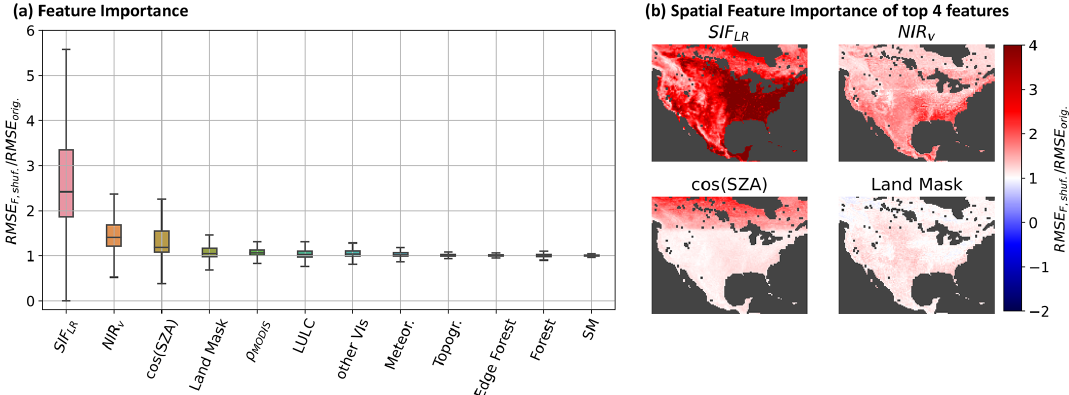
Figure 5. Feature importance. Panel (a) shows the total RMSE of the permuted feature divided by the RMSE without feature permutation, and (b) shows the RMSE of each pixel with permuted features divided by the RMSE without feature permutation. Some input variables are clustered, and all variables of that class are permuted at the same time. ρ MODIS : all seven MODIS bands; LULC: all 11 land cover classes; other VIs: kNDVI, NDVI, and EVI; Mereor.: temperature, precipitation, temperature with 16d delay, and precipitation with 16d delay; SM: surface soil moisture and subsurface soil